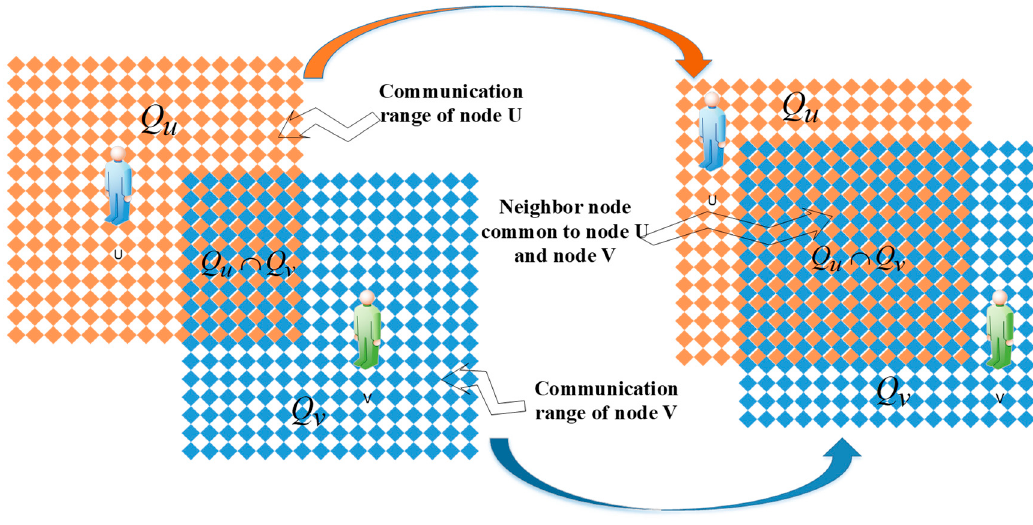
Figure 2. The physical change of the degree of mobile similarity between mobile nodes.